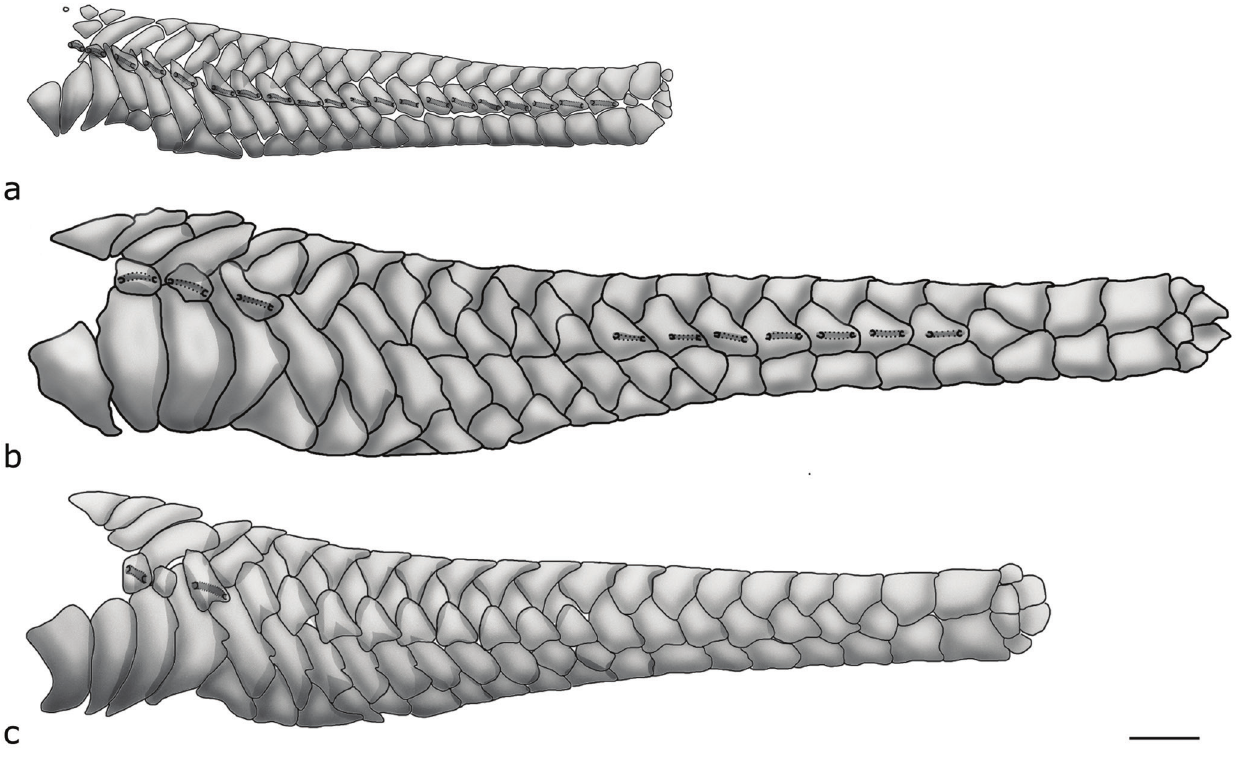
Fig. 2. Lateral plates of trunk (left side): a) Otothyris travassosi , MCP 418, undetermined sex, 15.5 mm SL. b) Otothyris travassosi , MCP 36716, female, 27.5 mm SL. c) Otothyris rostrata , MCN 18492, male, 23.6 mm SL. Scale bar =